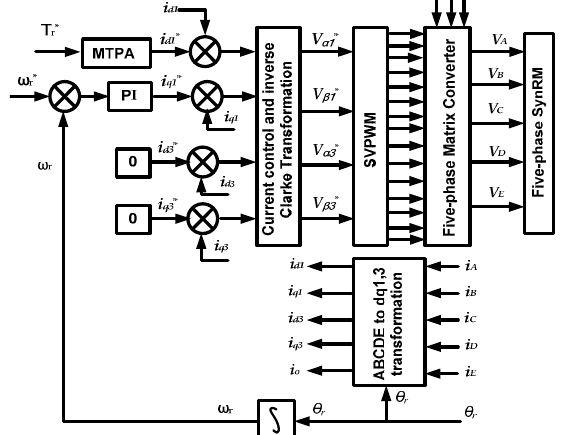
Figure 7. Block diagram of five-phase SynRM with MC under field-oriented control.